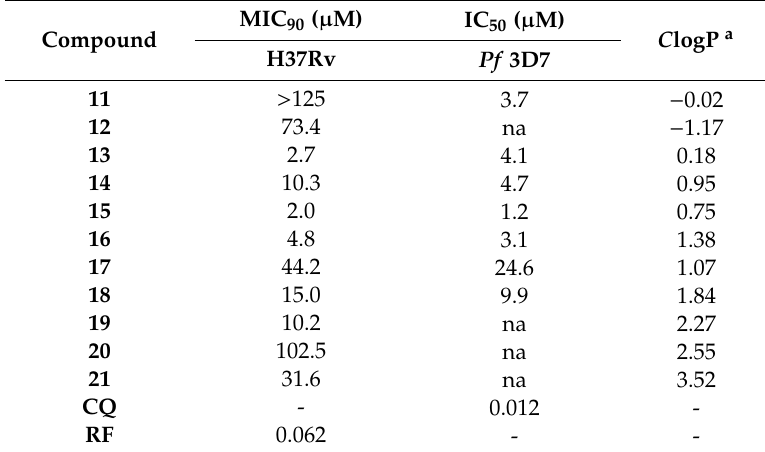
Table 1. In vitro antiplasmodial and antimycobacterial activities of quinolone-based thiosemicarbazones. MIC 90 ( µ M) IC 50 ( µ M) C logP a Compound H37Rv Pf 3D7 11 > 125 3.7 − 0.02 12 73.4 na − 1.17 13 2.7 4.1 0.18 14 10.3 4.7 0.95 2.0 1.2 0.75 44.2 1.07 15.0 9.9 1.84 19 10.2 na 2.27 20 102.5 na 2.55 21 31.6 na 3.52 CQ - 0.012 RF 0.062 -